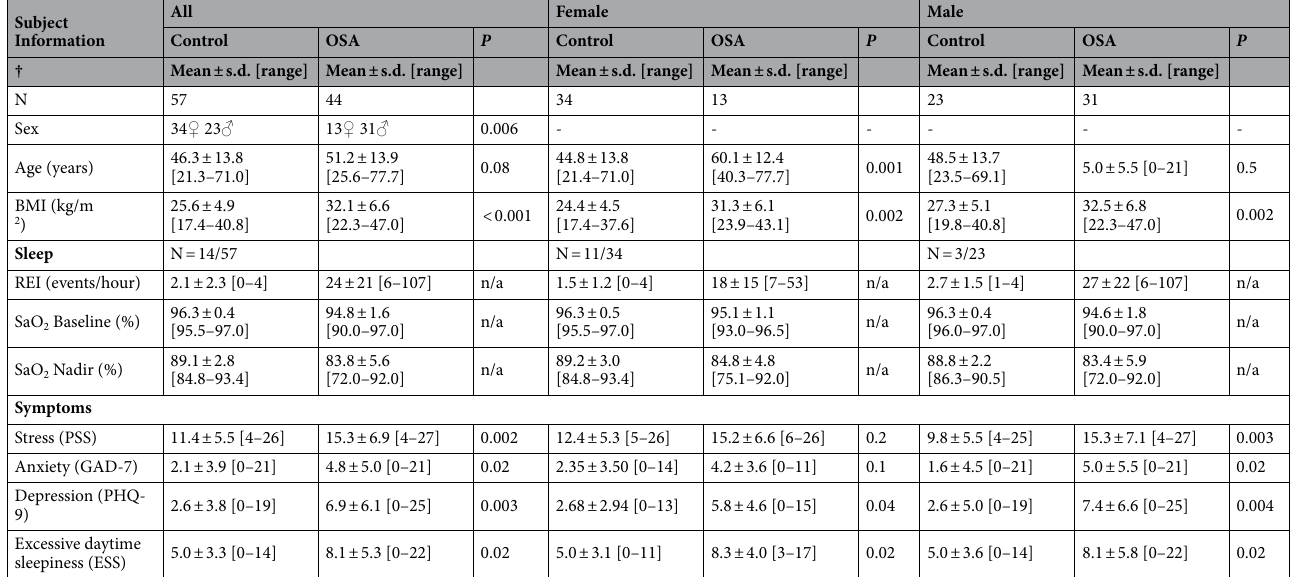
Table 1. Characteristics of participants. Mean, standard deviation and range for continuous variables are shown for OSA and control groups separately for combined-sex (All), female and male. P-values for OSA- control comparisons are based on two-tailed independent samples t-test for continuous variables and Chi- square for sex. n/a: tests not performed due to subset of control participants with sleep study. † BMI